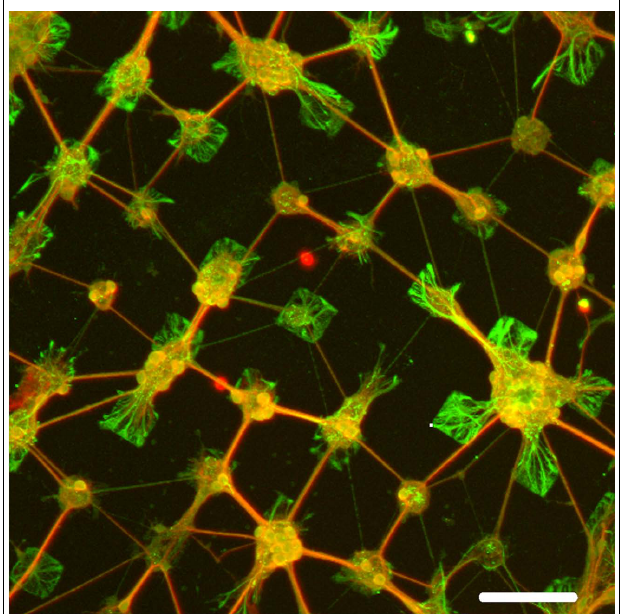
FIGURE 10 | Immunofluorescence staining of cultured brain cells on chips stamped with 50 μ m PDL pattern spaced by 50 μ m separation. Neurons are stained red with MAP2, while astrocytes are stained green with GFAP. Note the processes that extend mostly immediately neighboring squares. Scale bar: 100 μ m. From Charrier et al.